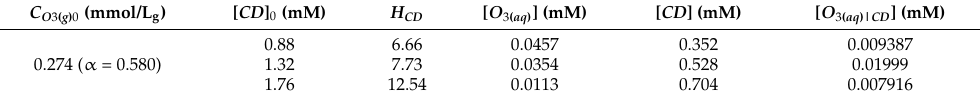
Table 1. Calculations of steady-state dissolved ozone concentrations at the water-CD